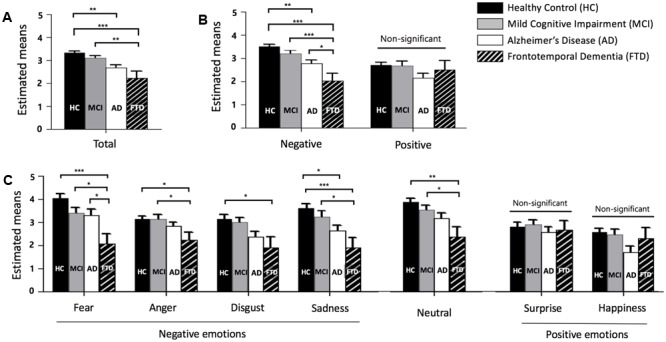
Facial emotion recognition scores across groups. (A) Total score (mean of fear, anger, disgust, sadness, neutral, surprise, and happiness). (B) Negative (mean of fear, anger, disgust, and sadness) and positive (mean of surprise and happiness) emotion. (C) Each emotion, error bars represent standard errors. HC = healthy control, MCI = mild cognitive impairment, AD = Alzheimer’s disease, and FTD = frontotemporal dementia. ∗p < 0.05, ∗∗p < 0.01, ∗∗∗p < 0.001.